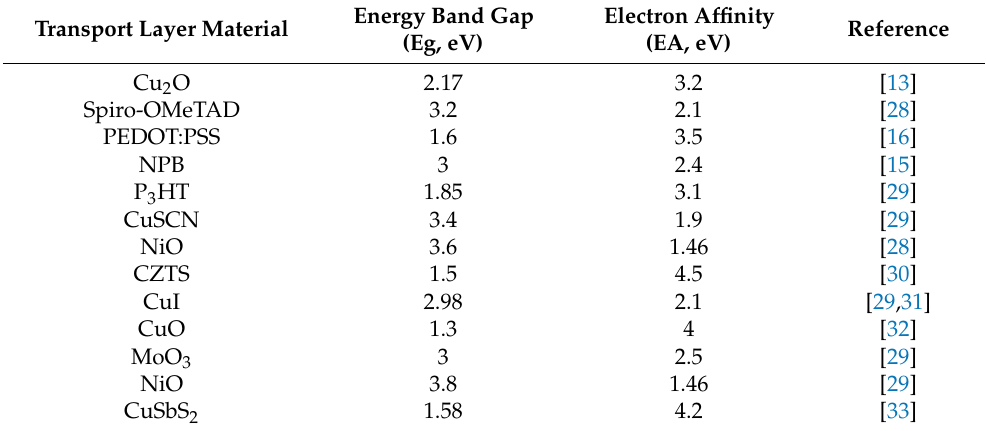
Table 2. Energy bandgap and electron affinity for commonly reported hole transport layer materials.